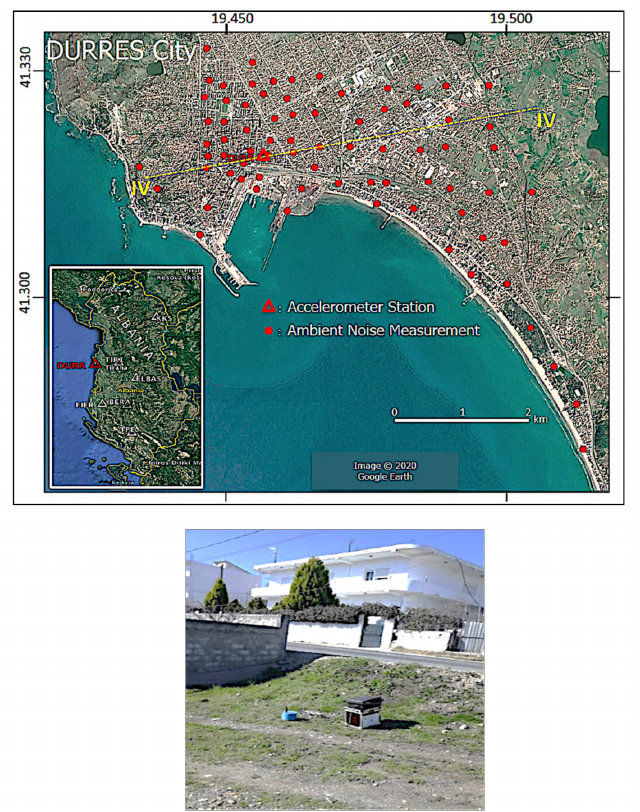
Figure 9. Measurement points within the Durres city ( top ); An example of measurement site ( bottom